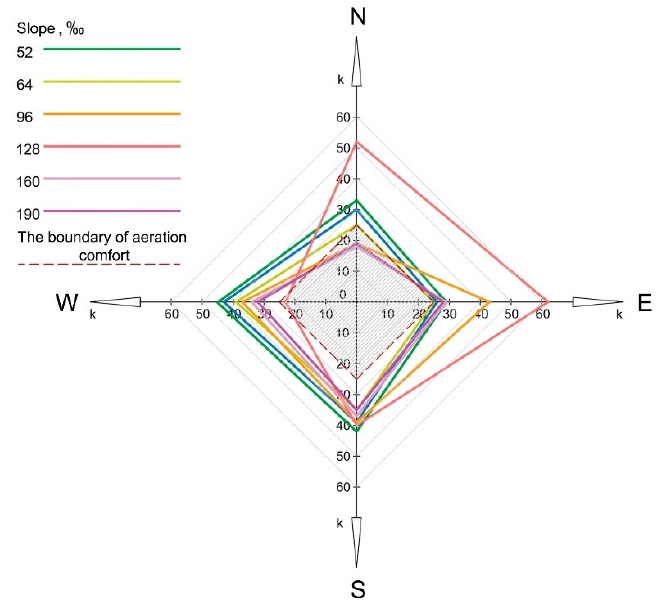
Figure 17. The petal diagram showing the breakdown of discomfortable zones k for the ribbon type of development, at gradients from 52–190‰, and four exposures of the slope.